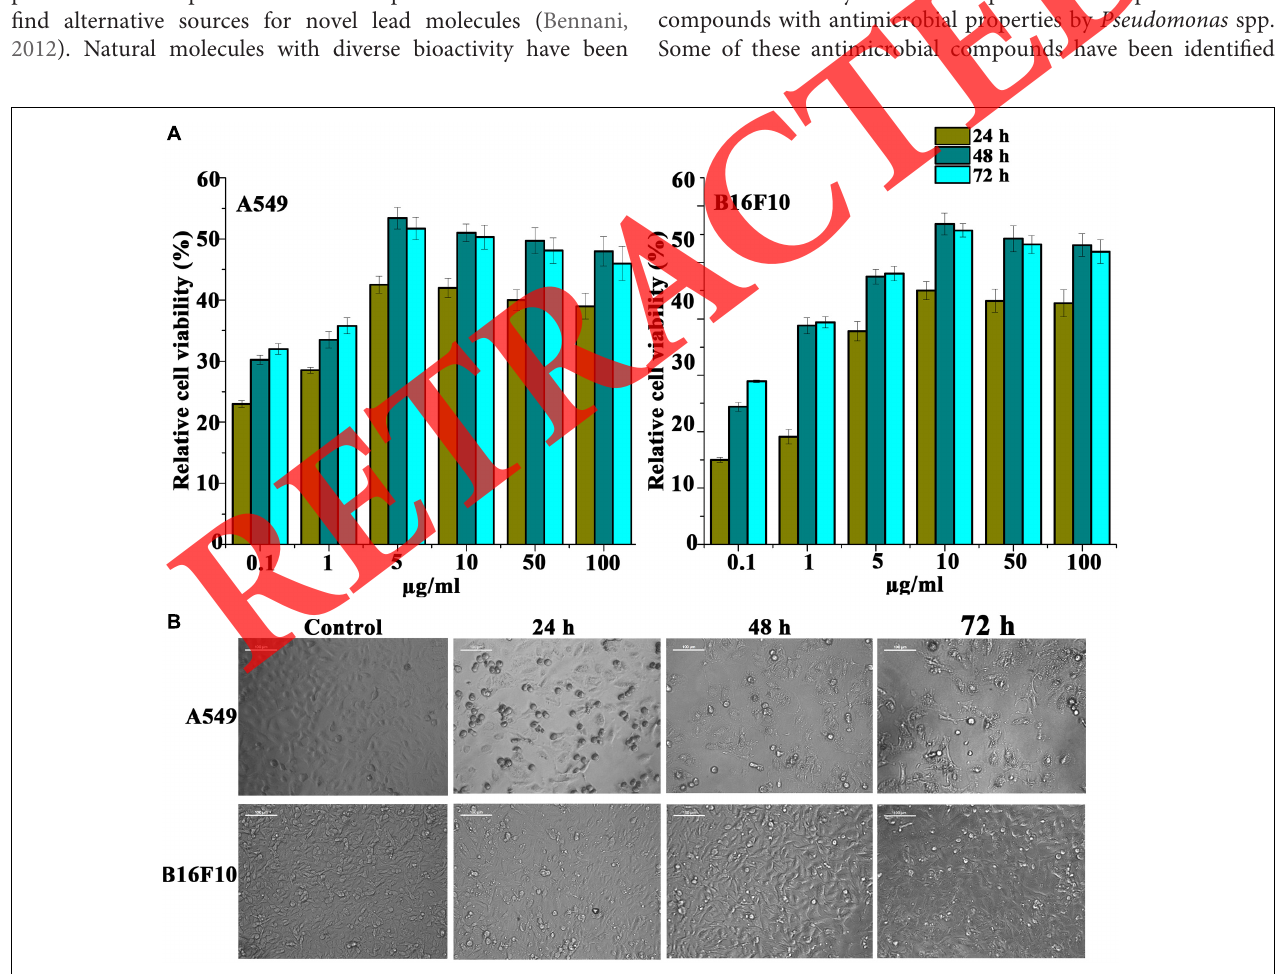
FIGURE 4 | (A) Cytotoxicity profile of Pseudopyronine B on A549 and B16F10 cells measured by MTT assay. (B) Phase contract images of A549 and B16F10 cells treated with Pseudopyronine B. The experiments where performed in three replication and results were expressed as mean ± standard deviation.